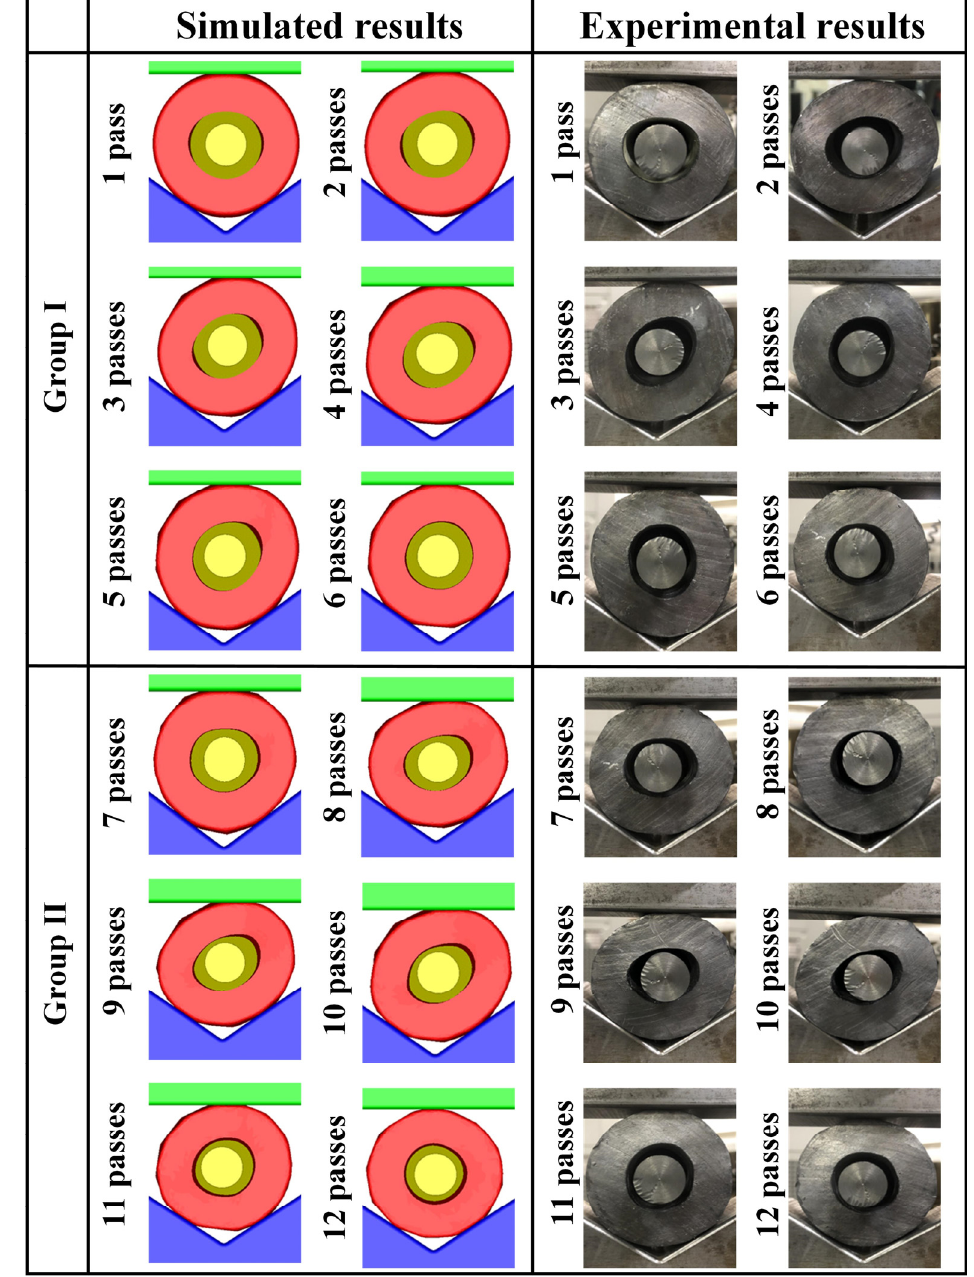
Figure 12. The MFN process of M3 scheme (the experiments with shrinkage ratio of 25:1).